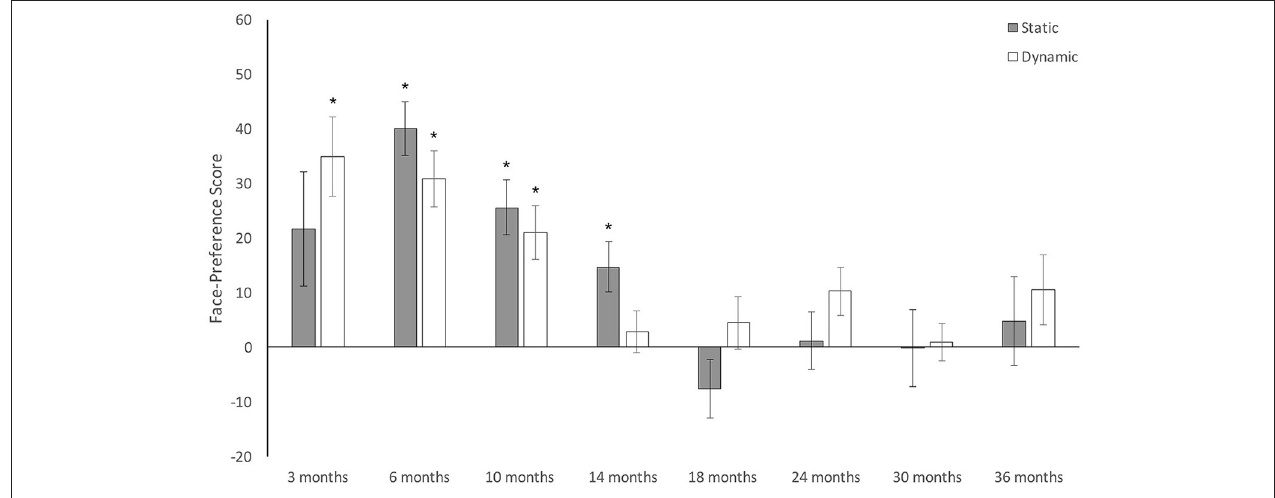
FIGURE 3 | Results from separate analyses on face preference scores at each age and for each stimulus type. Error bars are SEM. * p <